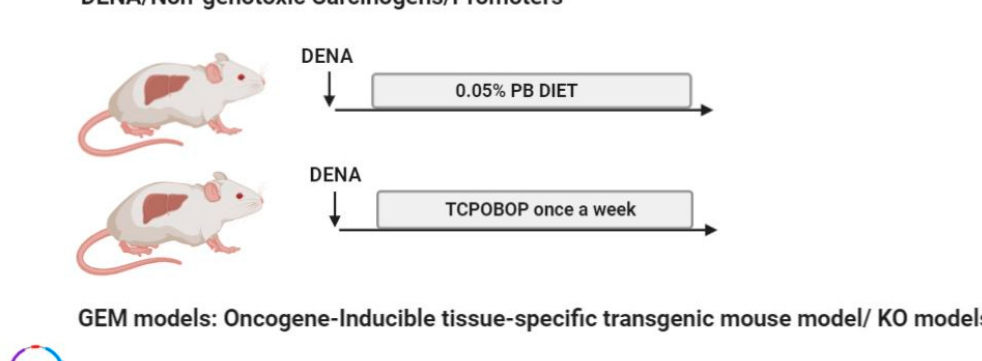
Hydrodynamic Injection.